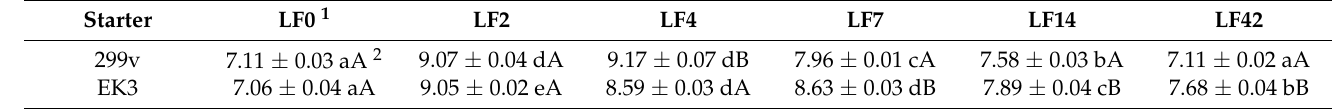
Table 2. Evolution of the LAB number in fermented mushrooms (log